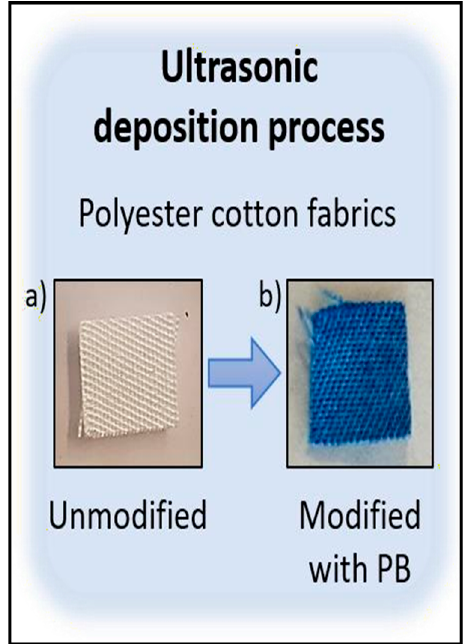
Figure 2. ( a ) Polyester cotton fabrics unmodified and ( b ) modified with Prussian Blue 0.25 mM by ultrasonic deposition.